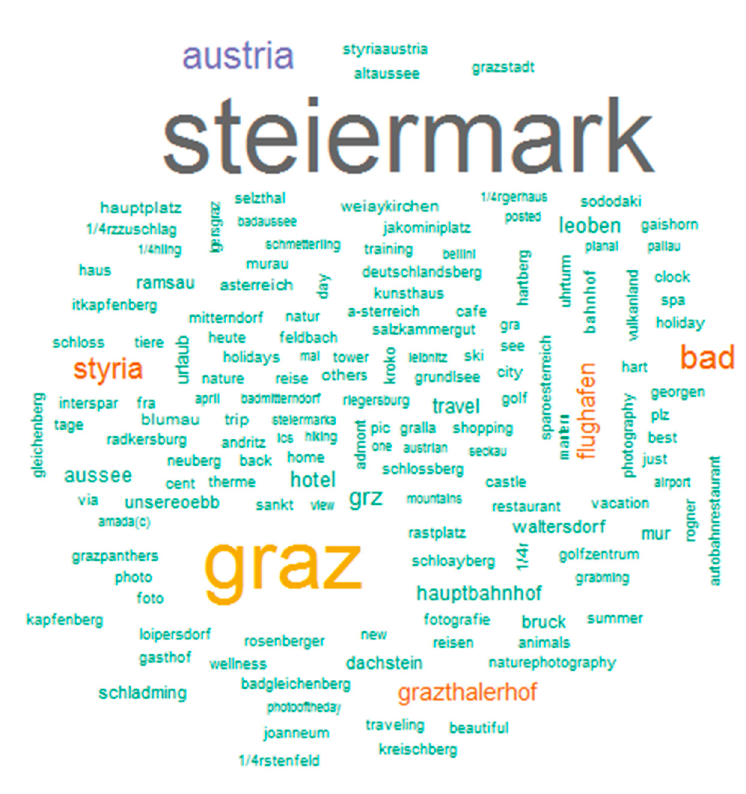
Figure 3. Word cloud of the 150 most frequent words in the twitter dataset.